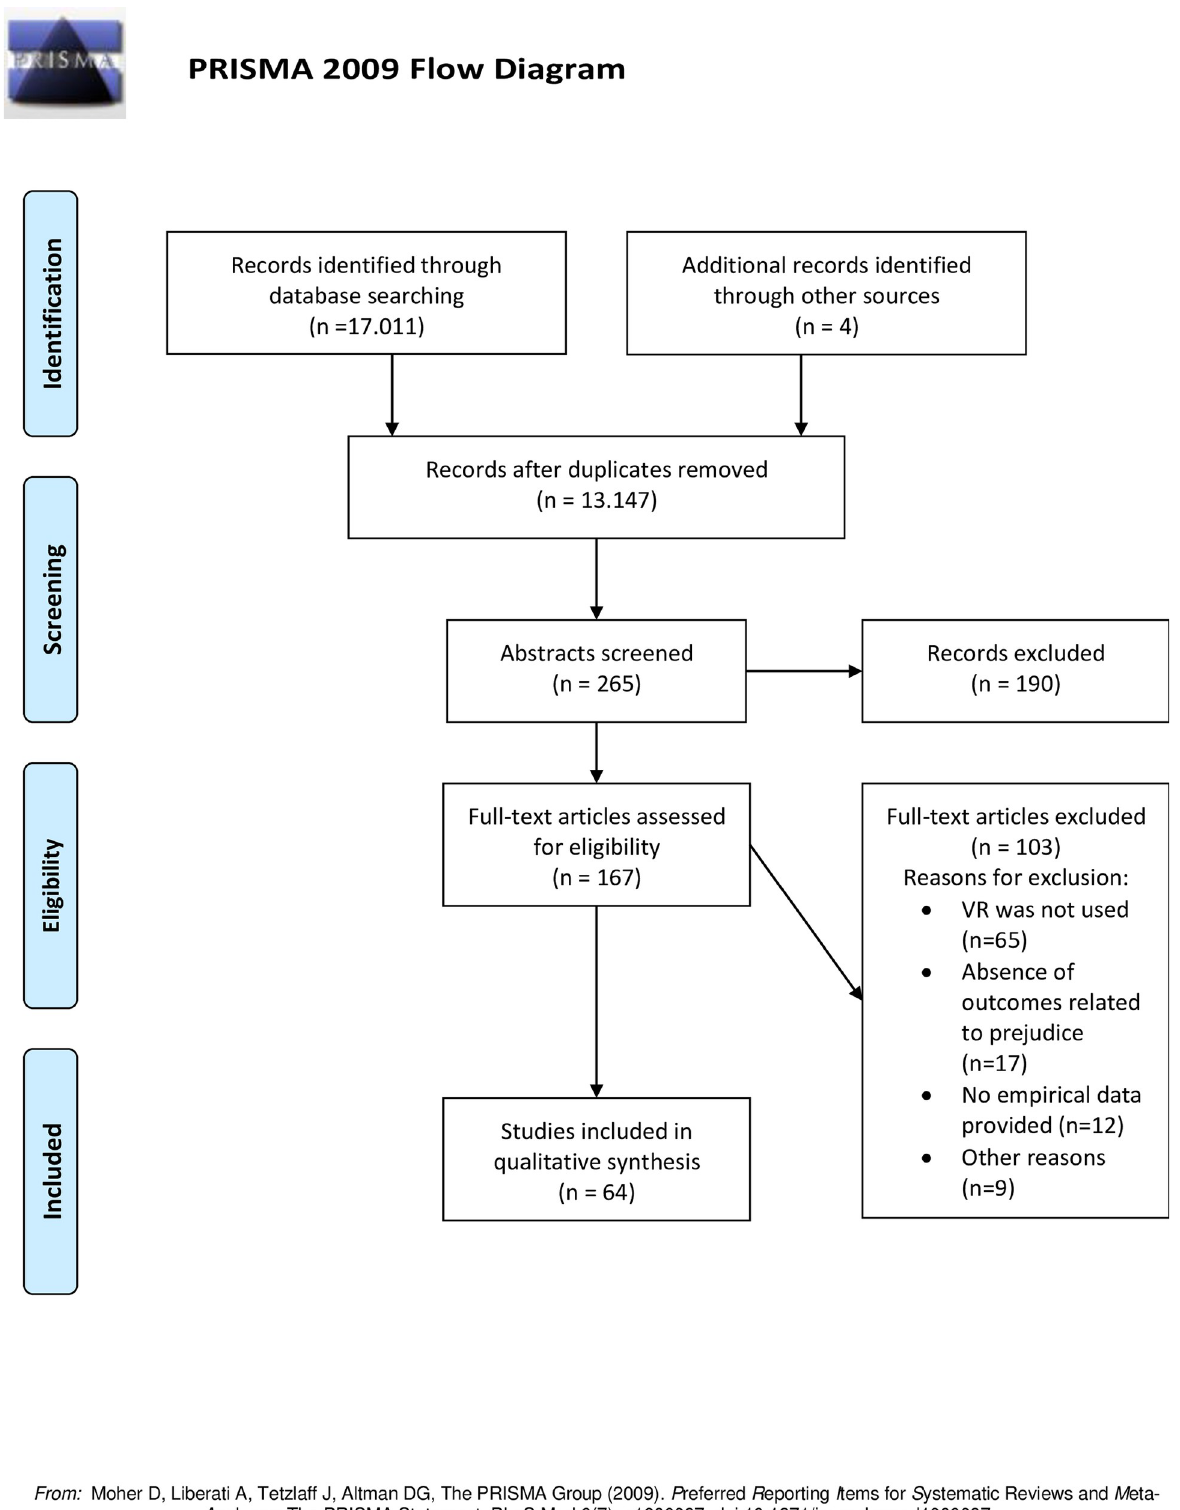
Fig 1. PRISMA flow